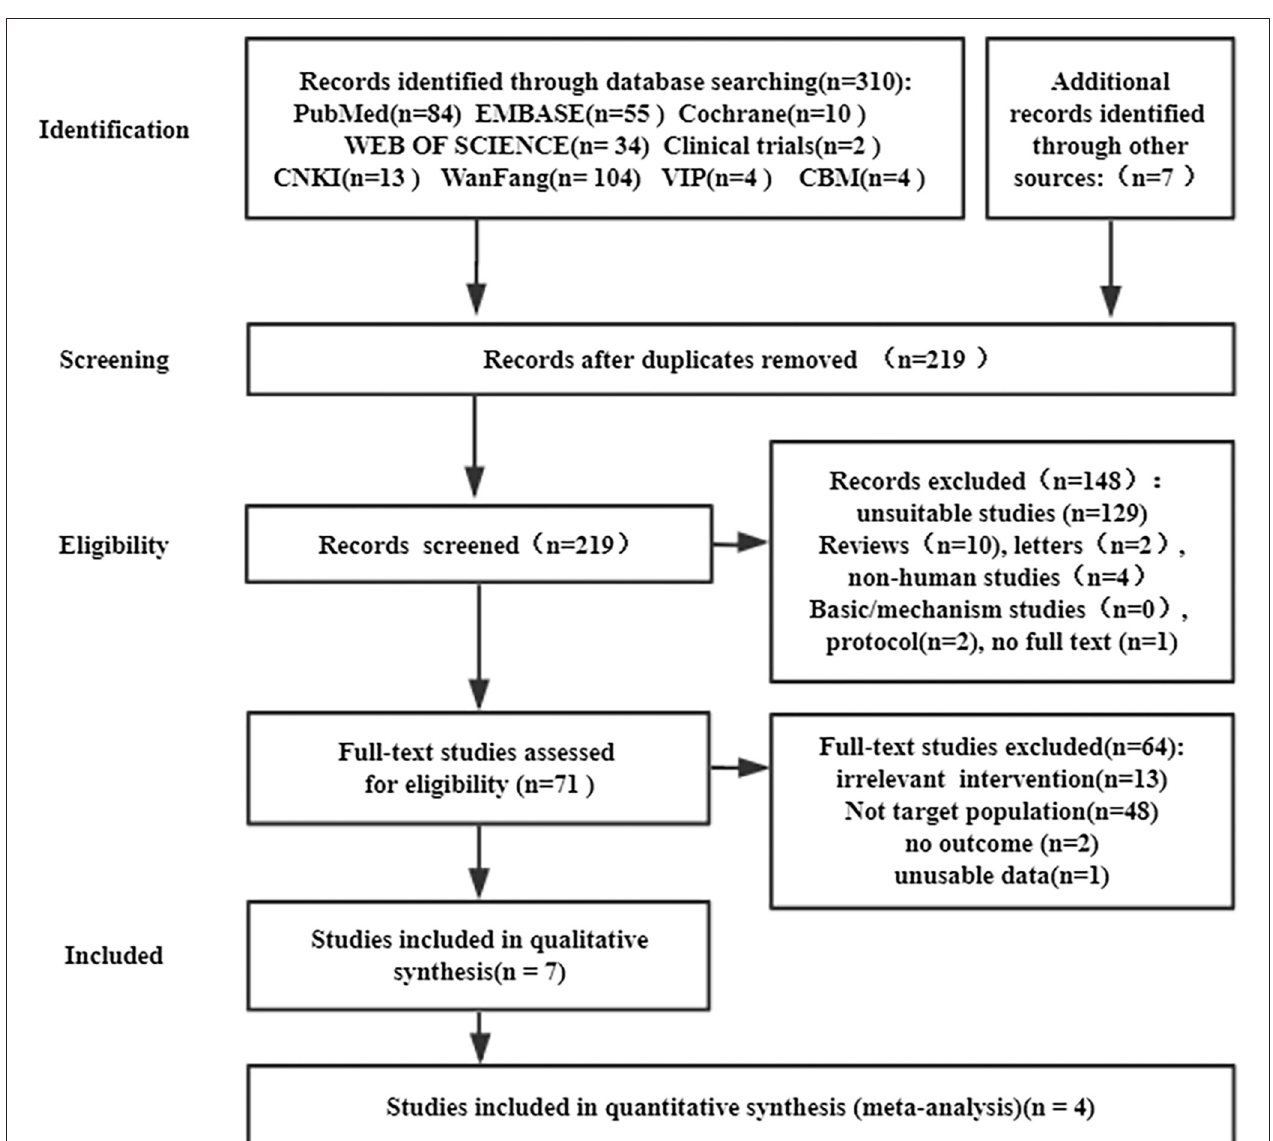
FIGURE 1 | PRISMA flow diagram of the literature search